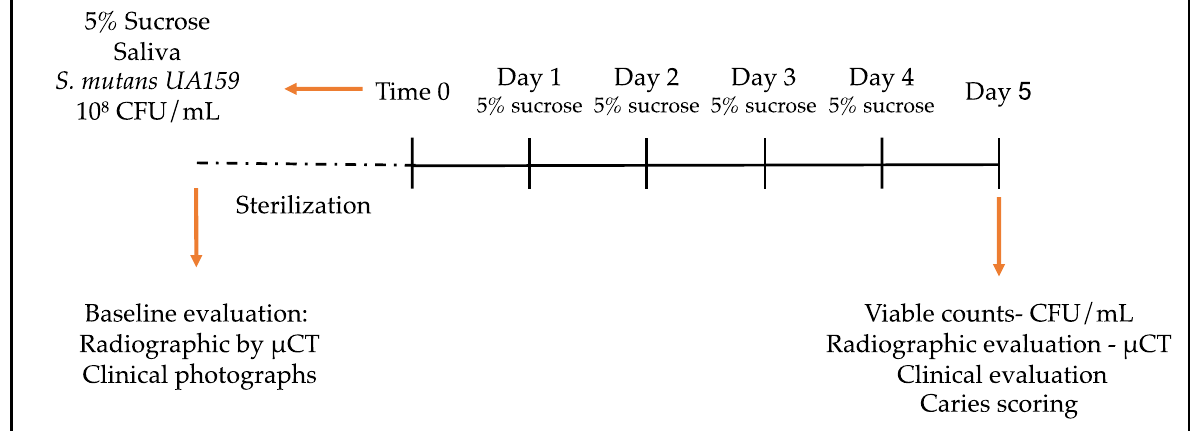
Figure 1. Schematic diagram summarized in vitro caries model over extracted jaws from healthy euthanized mice . Before subjecting the jaws to a caries-promoting environment, all jaws were photographed using an SMZ25 stereomicroscope (Nikon, Tokyo, Japan) and scanned using micro-computed tomography ( µ CT) ( µ CT 40, Scanco Medical, Switzerland). Then, all jaws were autoclaved. At time 0, jaws were subjected to saliva, bacterial infection by S. mutans UA159 , and 5% sucrose growth media. Growth media was replaced every 24 h. A group of five jaws served as a control group without bacterial infection. After 5 days, microbiological samples were collected using a low-speed dental bur 0.25 mm (MDT, Israel) for viable counts evaluation. Then, hemi-mandibles were photographed again using SMZ25 stereomicroscope and scanned using µ CT for demineralization quantification.